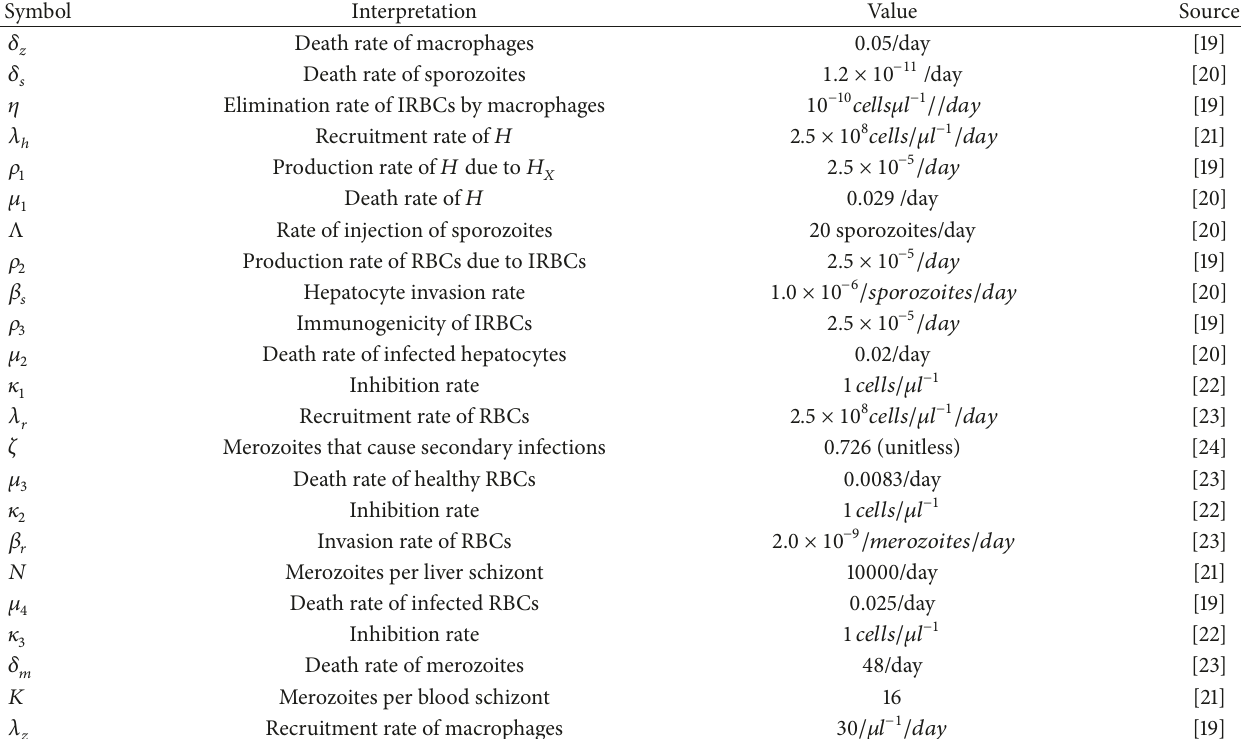
Table 3: Parameter values used in the numerical simulation and demonstration of the existence of endemic equilibrium point. See Table 2 for detailed parameter descriptions.